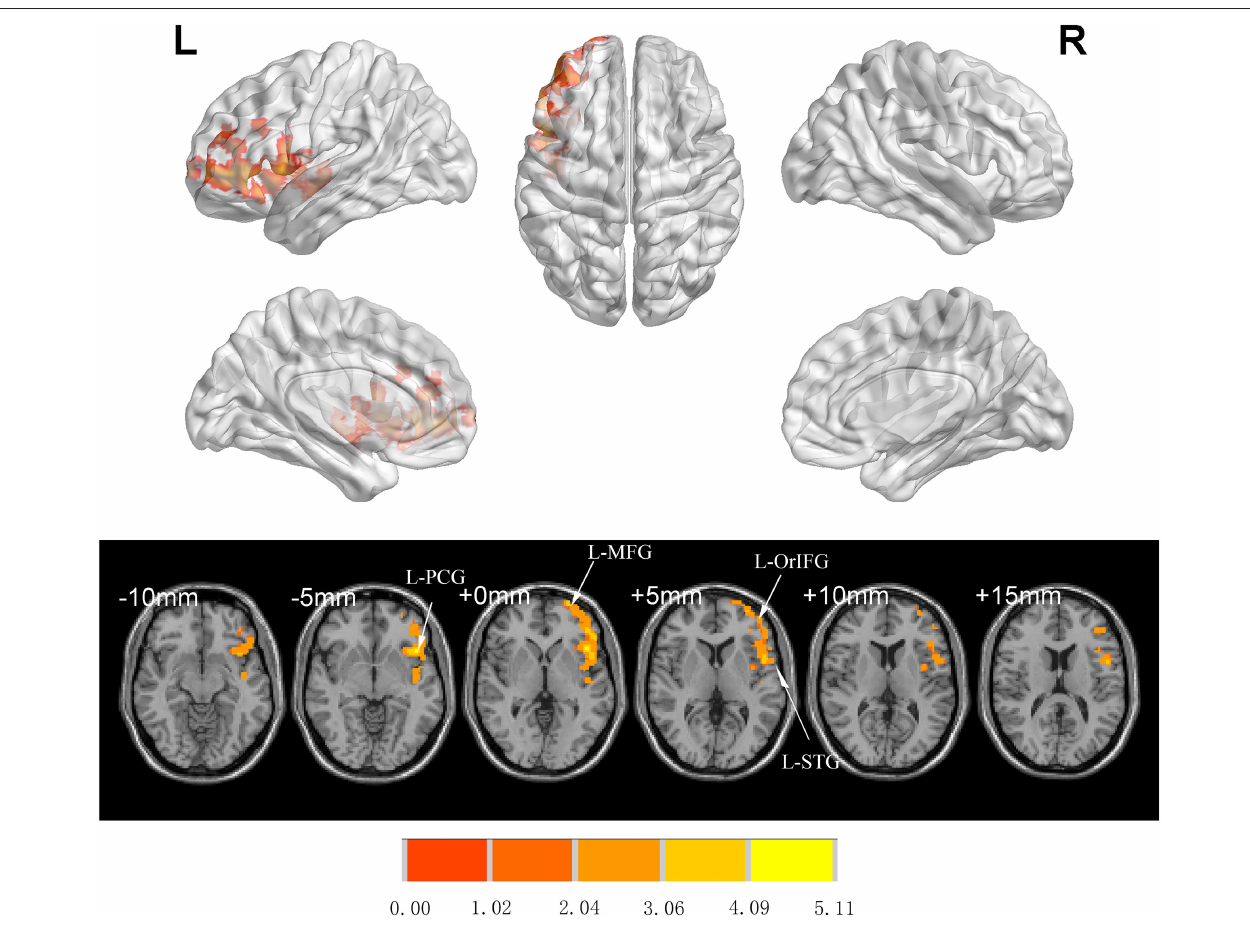
FIGURE 4 | Significant differences in FC between Groups I and C 7 days after surgery (voxel p < 0.05, GRF-corrected). Increased FC was observed in the L-orIFG, L-MFG, L-STG, and L-PCG in Group I compared to Group C. L-PCG, left precentral gyrus; L-MFG, left middle frontal gyrus; L-OrIFG, left orbital inferior frontal gyrus; L-STG, left superior temporal gyrus; FC, functional connectivity; GRF, gaussian random field.